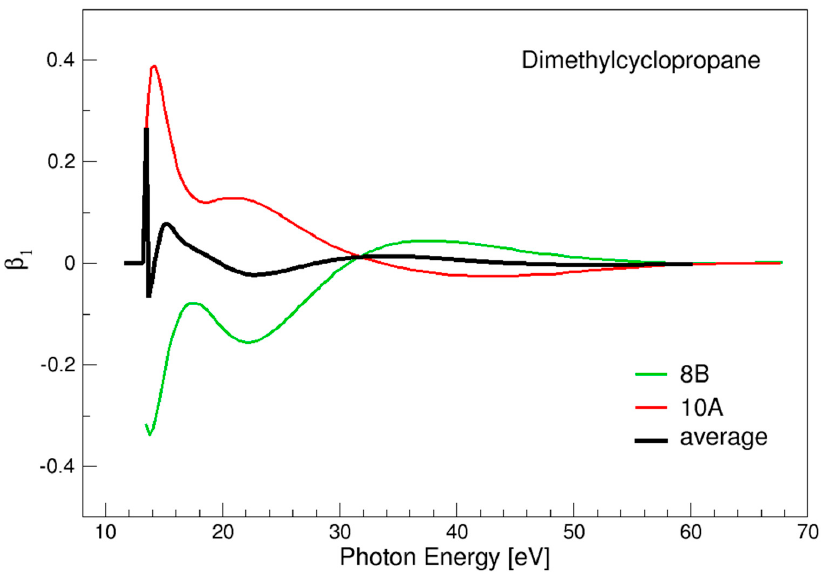
Figure 4. β 1 parameter for the next two outermost ionizations, 10A and 8B, and the average value, in dimethylcyclopropane.